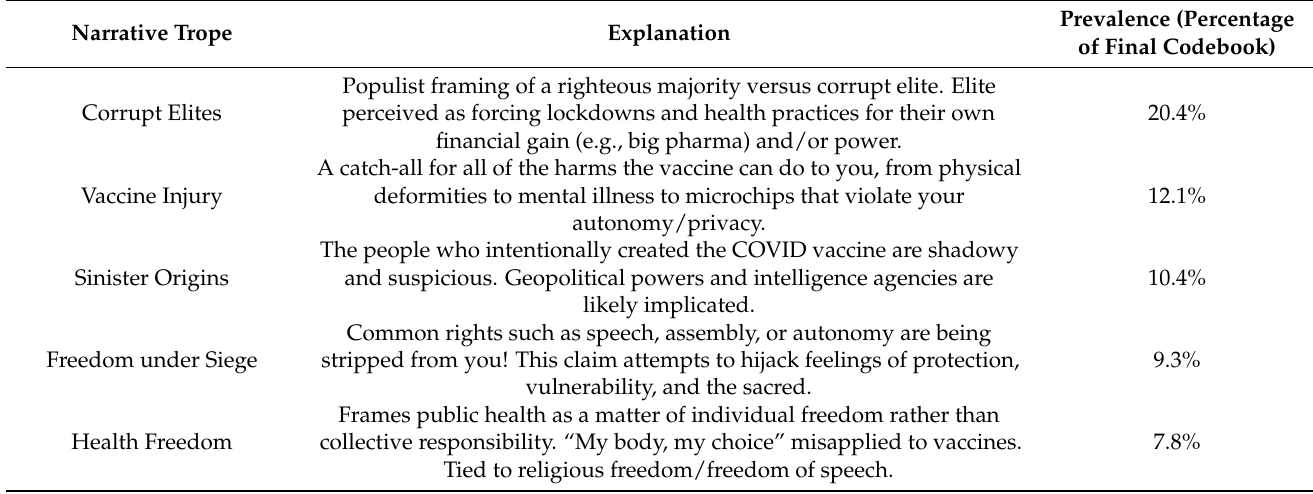
Table 1. Top codes by